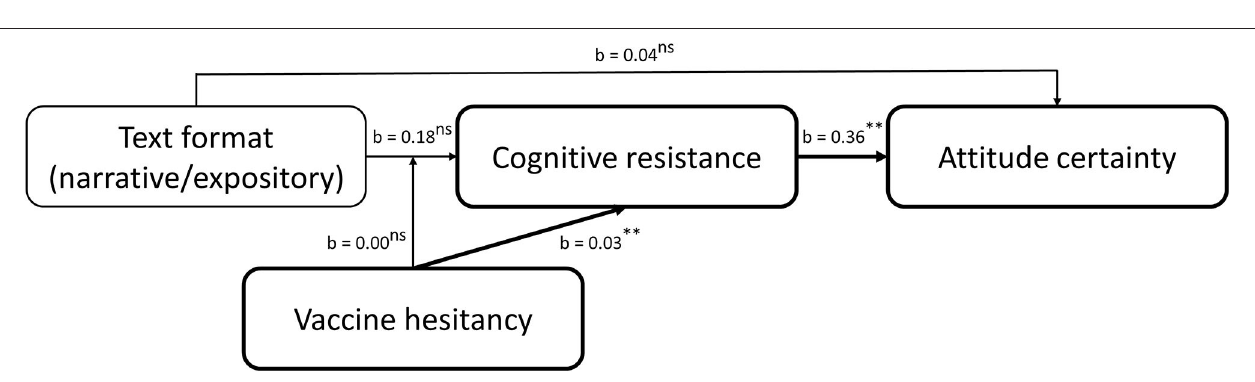
FIGURE 6 | Moderated mediation on attitude certainty. ns, non-significant; ** p <